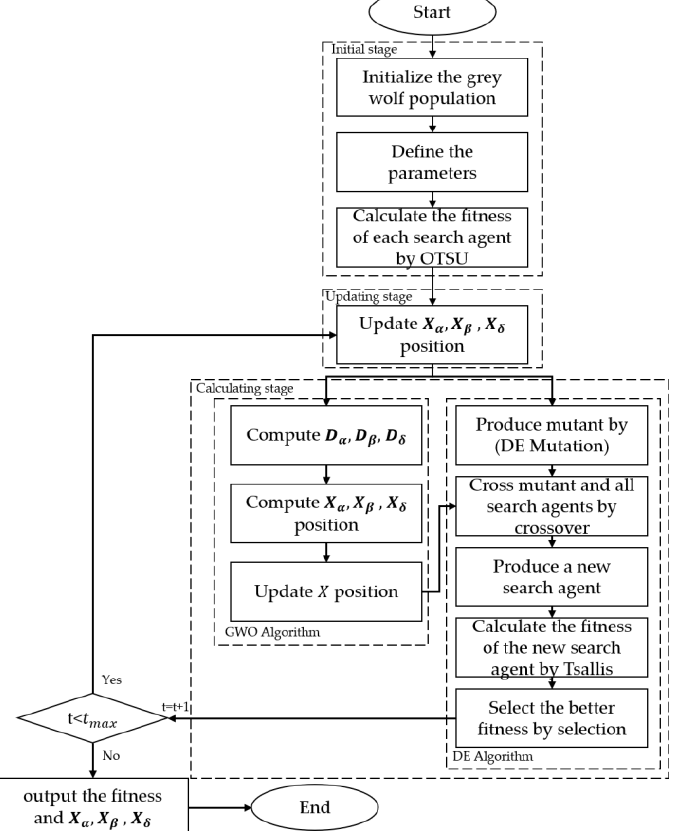
Figure 1. The flowchart of DE-OTSU-GWO algorithm.